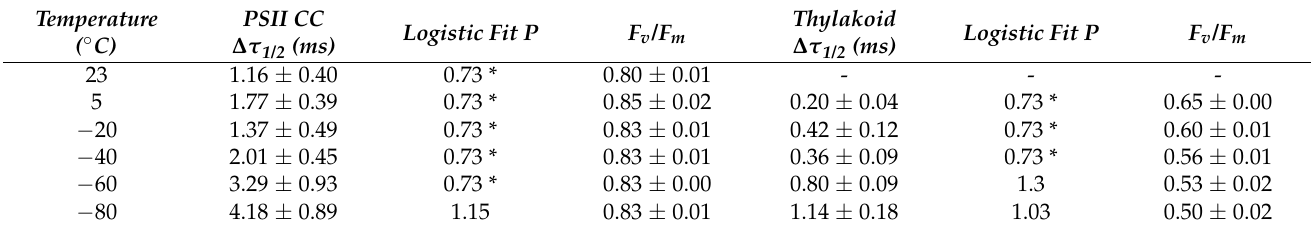
Figure 3. Dependence of the F 1 -to- F 2 Chl- a fluorescence levels on the ∆ τ time intervals between the first and second STSFs at different temperatures in PSII CC of T. vulcanus ( a ), and in spinach TMs ( b ) in the presence of 40 µ M DCMU. Continuous lines represent logistic-function fits of the data points, which are shown as mean values ± SD ( n = 3–9). Dotted vertical lines mark the ∆ τ 1/2 half-rise time values, i.e., the ∆ τ values corresponding to the 50% of the maximum F 1 -to- F 2 increments at 5 ◦ C (blue) and − 80 ◦ C (red). The fluorescence levels at each ∆ τ were determined after the second STSF; here marked as F 1,2 , irrespective of the resolution of the F 1 and F 2 levels (see Figure 2). The measurements were performed on the PAM-101 based setup. Table 1. Double-STSF induced ( F 1 -to- F 2 ) ∆ τ 1/2 half-rise times of PSII CC of T. vulcanus and spinach TMs in the presence of DCMU at different temperatures. Measurements were performed, using the PAM-101 based setup, on the same PSII CC batch and the same TM preparations at all temperatures. P is the slope of the rise curve calculated by logistic-function fit of the data points, which represent mean values ± SD ( n = 3–9). Numbers marked with the symbol * are obtained from a global fit with shared P (0.73); at low temperatures ( ≤− 60 ◦ C), the global fit was not satisfactory, and we allowed free run of the fit. The F v / F m parameter values are also